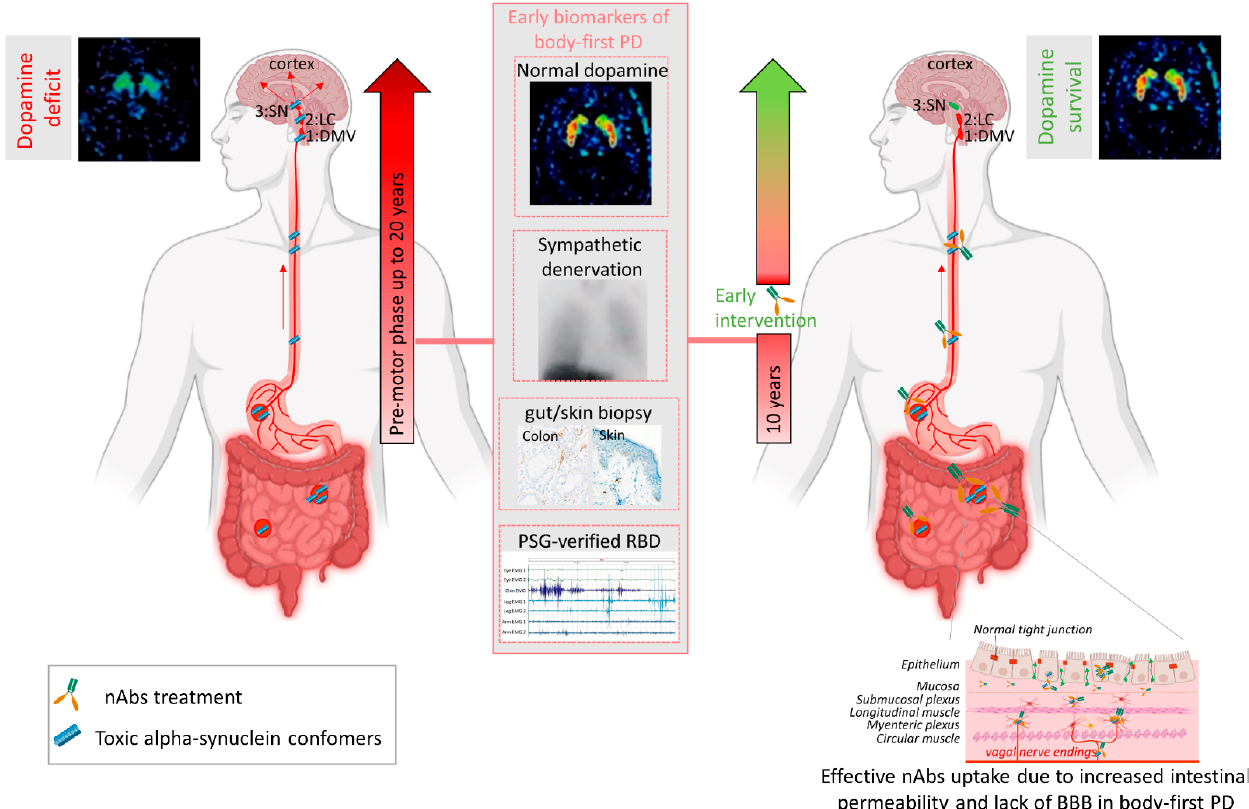
Figure 2. Passive immunization of pre-motor body-first PD patients enhances dopamine survival. Patients with probable prodromal body-first PD could be identified by a combination of several early biomarkers, such as the presence of pathological alpha-synuclein ( α syn) in skin and/or gut biopsies, polysomnography-verified RBD, cardiac sympathetic denervation on MIBG scintigraphies, but normal or near-normal nigrostriatal dopaminergic innervation on DaT SPECT. Such detailed phenotyping in the pre-motor phase might reveal body-first PD, allowing early intervention and optimal patient selection for clinical trials. Pre-motor start of nAbs treatment increases treatment efficacy by delaying or blocking peripheral-to-brain propagation of pathology, before any irreversible damage to the dopamine system is done, hereby enhancing the probability of dopamine survival in body-first PD. Furthermore, increased gut permeability in prodromal body-first PD patients with ‘leaky gut’ or increased intestinal permeability might yield a better uptake of the administered nAbs near the source of pathogenic α syn conformers, resulting in a better treatment efficacy, as opposed to brain-first cases where the source is located in the brain and only 0.1–0.2% of